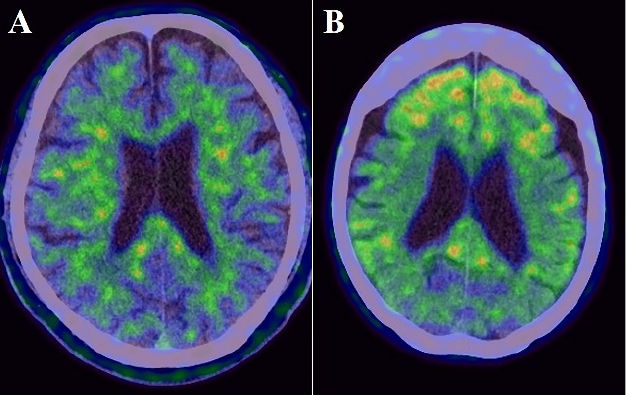
Figure 2. Examples images of an individual with lower PiB uptake ( A : cortical SUVR value = 0.804) and with higher PiB uptake ( B : cortical SUVR value = 2.584).